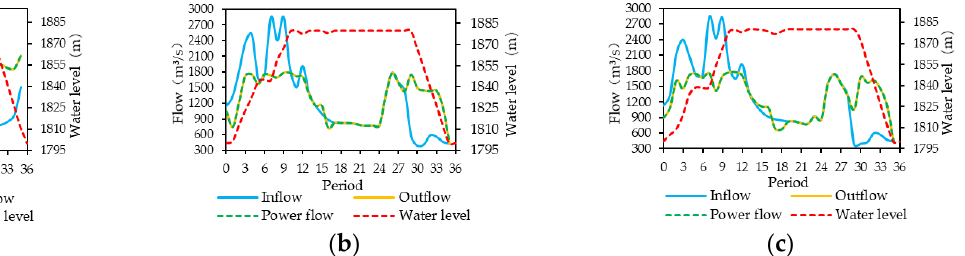
Figure 7. Operation hydrographs of the Jinxi Reservoir using ( a ) Scheme 1, ( b ) Scheme 2 and ( c ) Scheme 3.